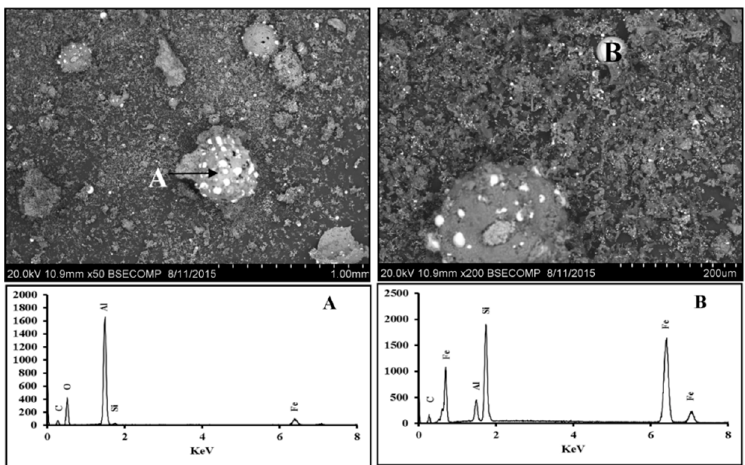
Figure 8. The HRSEM/EDS images for the reacted assembly after heat treatment for 60 min at 1550 °C. Phases A and B were also detected after 30 min of heat treatment.